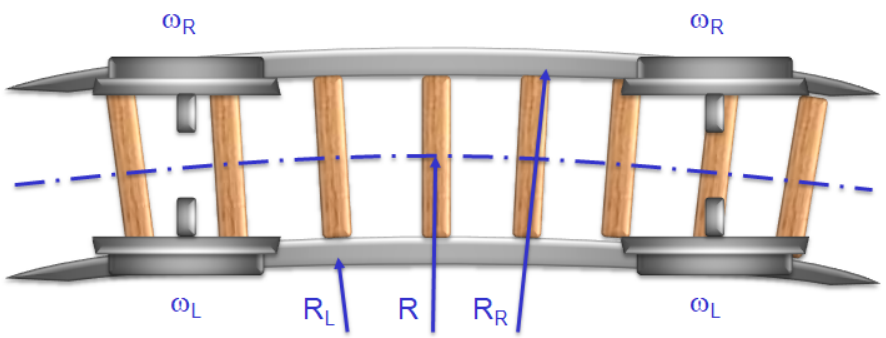
Figure 14. Movement of a trolley on the curve of the track.